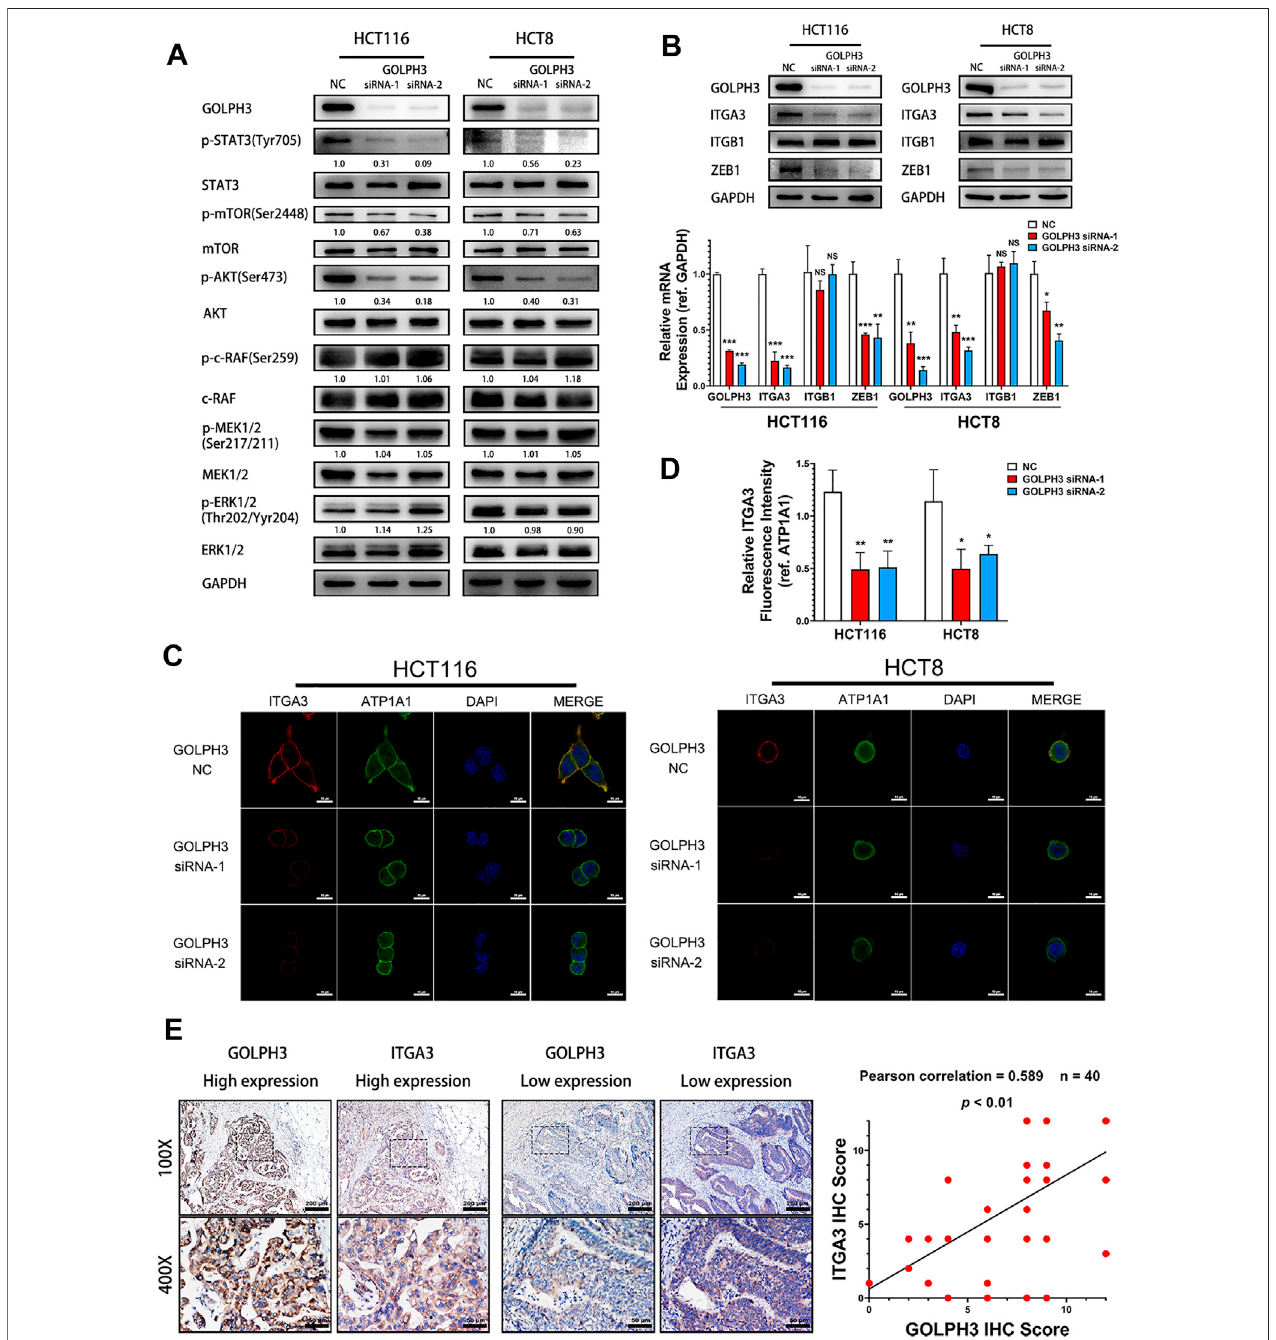
FIGURE 3 | GOLPH3 knockdown suppresses STAT3 phosphorylation and the expression of ZEB1 and integrin α 3. (A) The phosphorylation level of STAT3 (Tyr705), AKT (Ser473), mTOR (Ser2448), c-Raf(Ser259), MEK1/2(Ser217/211) and ERK1/2(Thr202/Yyr204) of control and GOLPH3 siRNA transfected HCT116 and HCT8 cells were assessed using western blotting. (B) Expression of integrin α 3, integrin β 1 and ZEB1 of control and GOLPH3 siRNA transfected cells were assessed using western blotting and qRT-PCR. (C,D) Immuno fl uorescence staining showed the expression of integrin α 3 and ATP1A1 in control and GOLPH3 siRNA transfectedcells.ATP1A1 wasusedastheplasmamembranemarker.Scalebar,100 µm. (E) RepresentativeImmunohistochemicalimagesofGOLPH3andintegrin α 3 in 40 cases of CRC tissues. The areas in the rectangles in the top columns (100×, Scale bar, 200 µm) were shown at higher magni fi cation (×50, Scale bar, 50 µm) in the bottom columns. Immunohistochemical scores of GOLPH3 and integrin α 3 exhibited a positive correlation. For (A,B) , results were reproduced in three independent experiments, and representative immunoblots are shown. * p < 0.05, ** p < 0.01, *** p < 0.001.